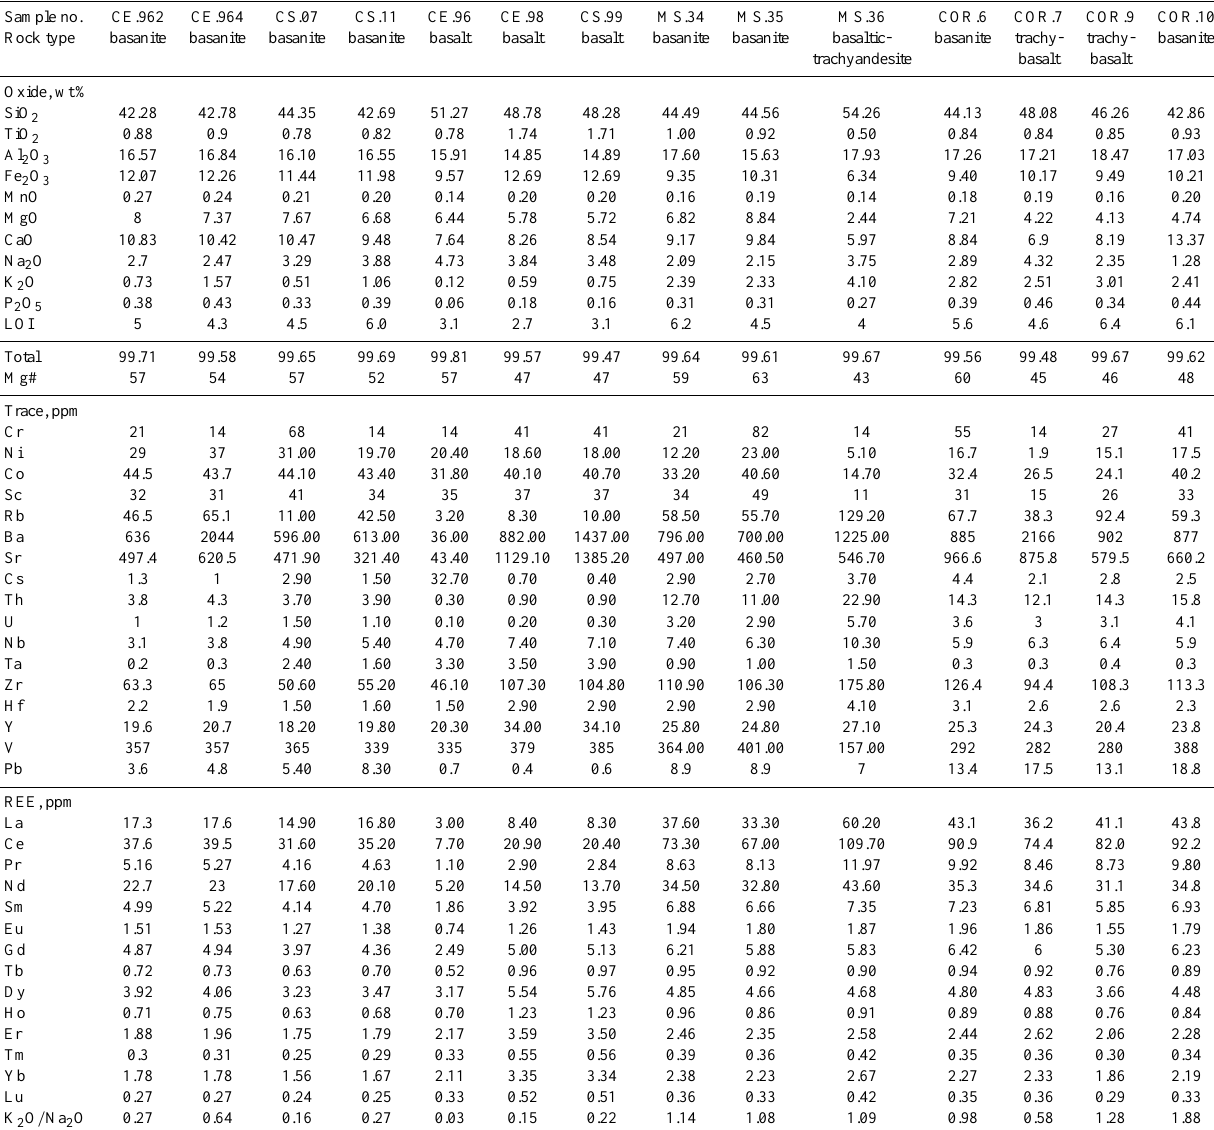
Table 8. Major, trace element and REE data for a select group of island arc volcanic rocks from the Ankara Mélange. Sample